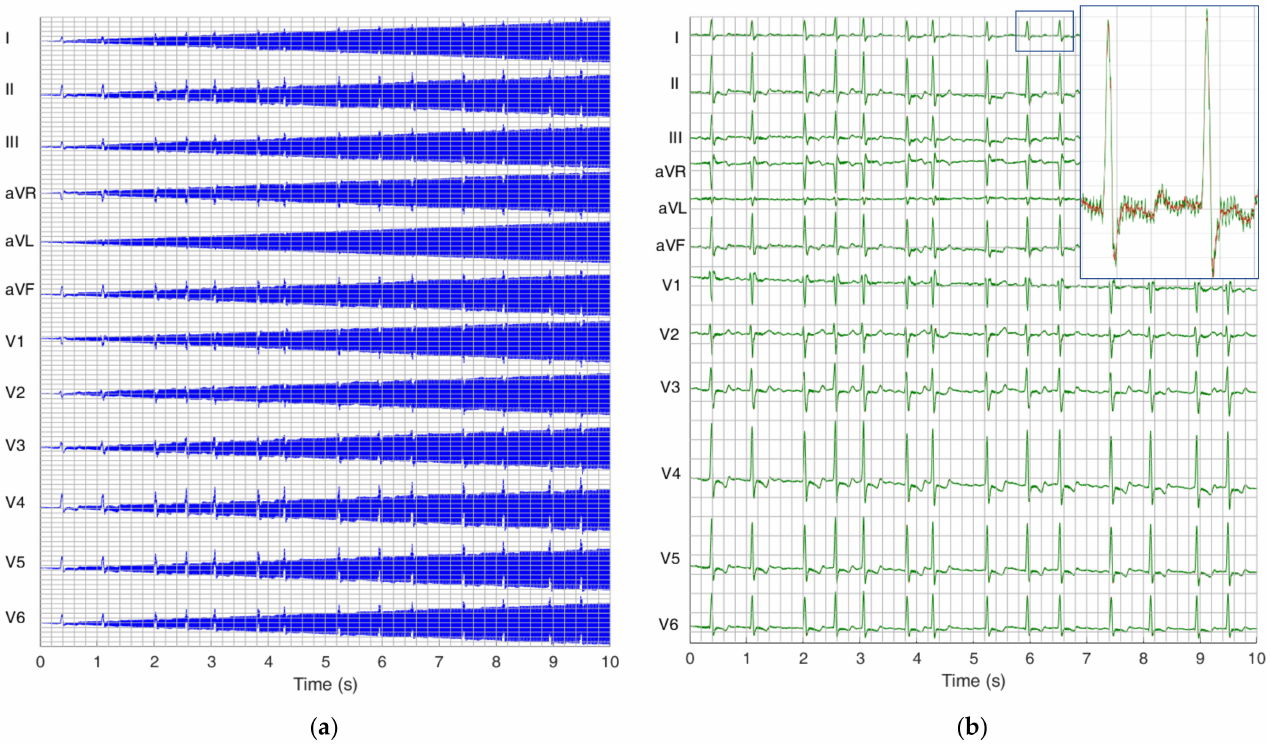
Figure 14. Example of 10 s 12-lead ECG trace (s0546_re.dat from PTB Diagnostic ECG database) shown in a grid (200 ms/div, 500 µ V/div): ( a ) 12-lead ECG superimposed by PLI (50 Hz) with linearly changing amplitude over 10 s at the extreme slew rate (200 µ V/s); ( b ) filtered 12-lead ECG by SF algorithm with 10 × zoomed segment of lead I (1 s, 50 µ V/div), showing the overlap between original ECG (red) and filtered ECG (green). The y-scaling of 12 ECG leads retains no inter-lead overlap; thus, ECG in ( b ) is a zoomed-in representation of ( a ) after filtering of the large PLI component.